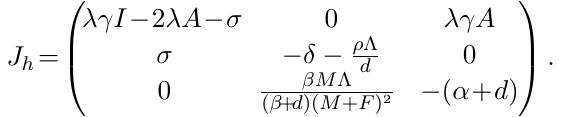
P ARAMETER VALUES USED IN F IGURE